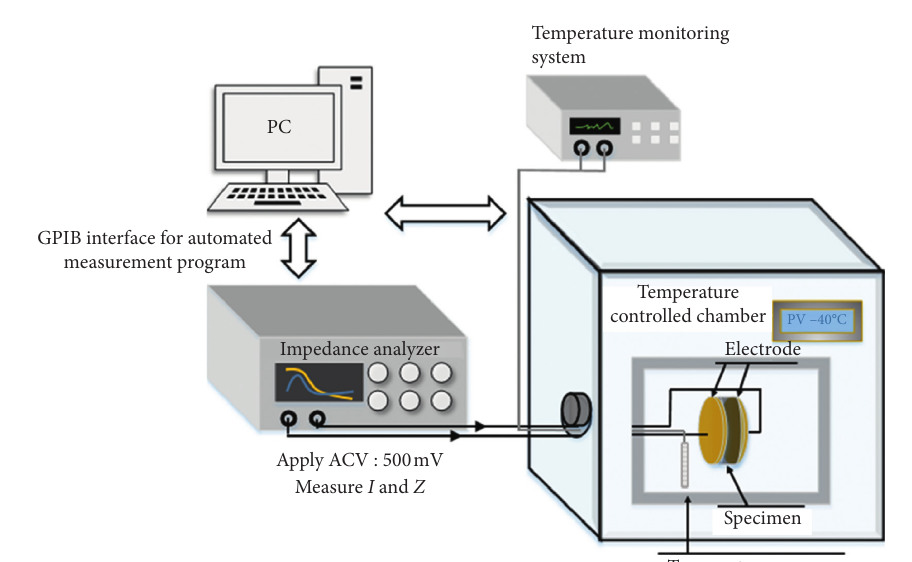
Figure 1: Configuration of the automatic impedance spectroscopy system for measuring the complex dielectric